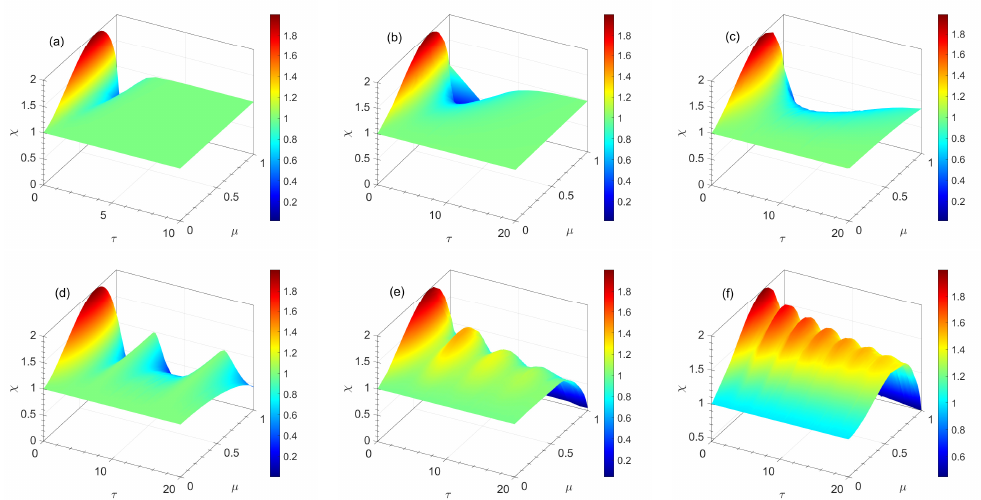
Figure 7. Dense coding capacity versus scaled time τ = γ 0 t and parameter µ for different values of Stark shift parameter β in Markovian regime [( a ) β = 0, ( b ) β = 10 γ 0 , and ( c ) β = 15 γ 0 ] with λ = 10 γ 0 and in non-Markovian regime [( d ) β = 0, ( e ) β = 0.5 γ 0 , and ( f ) β = γ 0 ] with λ = 0.1 γ 0